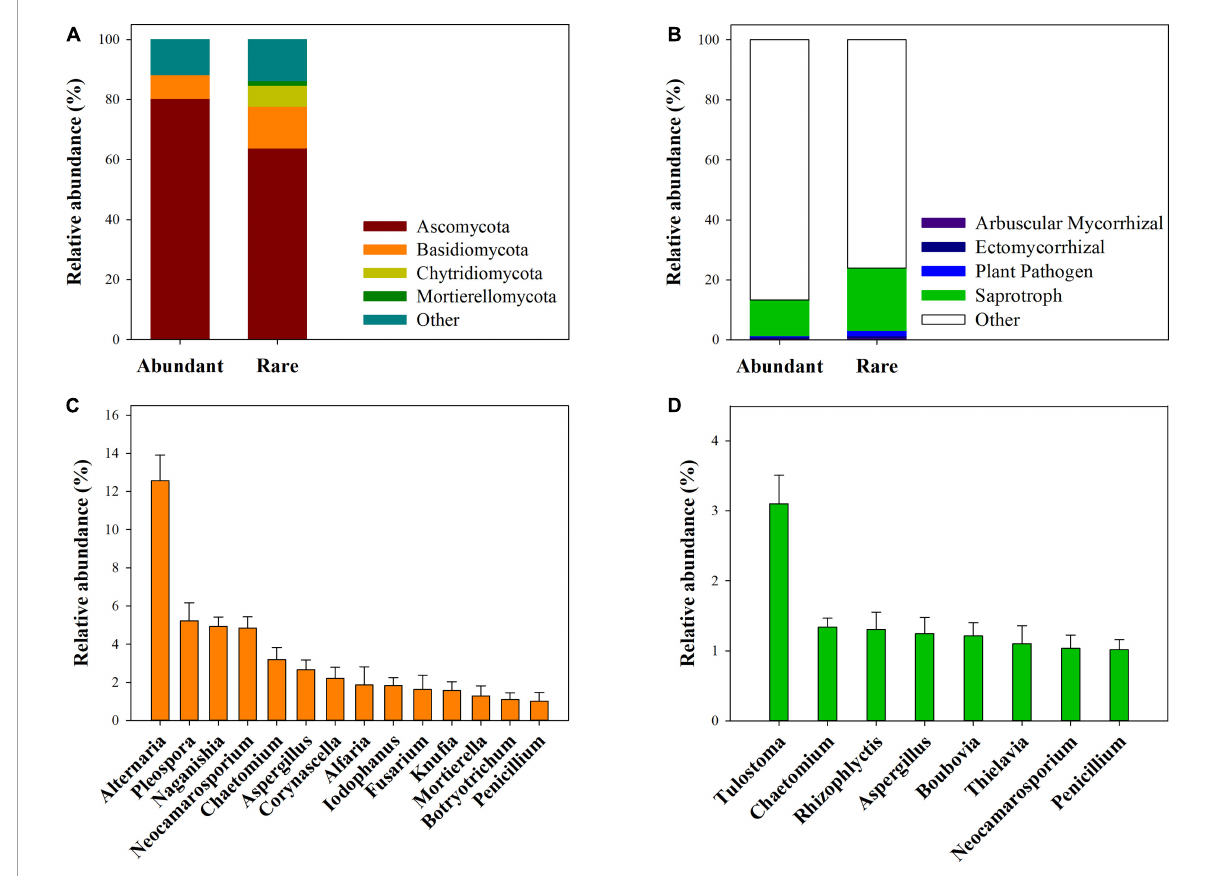
FIGURE1 Taxonomic and functional composition of abundant and rare fungal sub-communities. (A) Showed dominant phylum and their total relative abundance for the abundant and rare fungal subcommunities. (B) Showed total relative abundance of Saprotrophic, Arbuscular Mycorrhizal, Ectomycorrhizal, and Plant-pathogen fungal. (C,D) Showed the dominant genera and their average relative abundance for the abundant and rare fungal subcommunities across 90 samples.